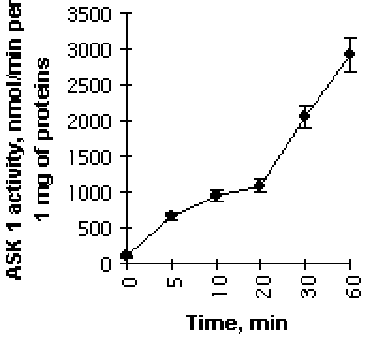
Fig. 1 . Dependence of ASK 1 activity in the rat liver homogenate on the time of homogenate incubation with sodium nitroprusside.